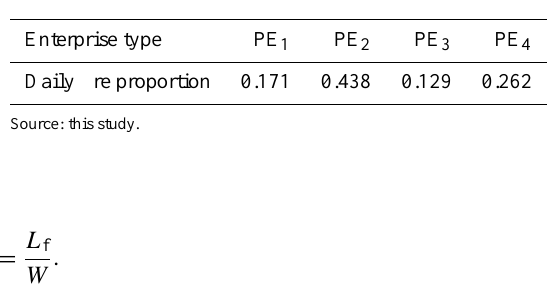
Table 4. Daily fire proportion for petrochemical